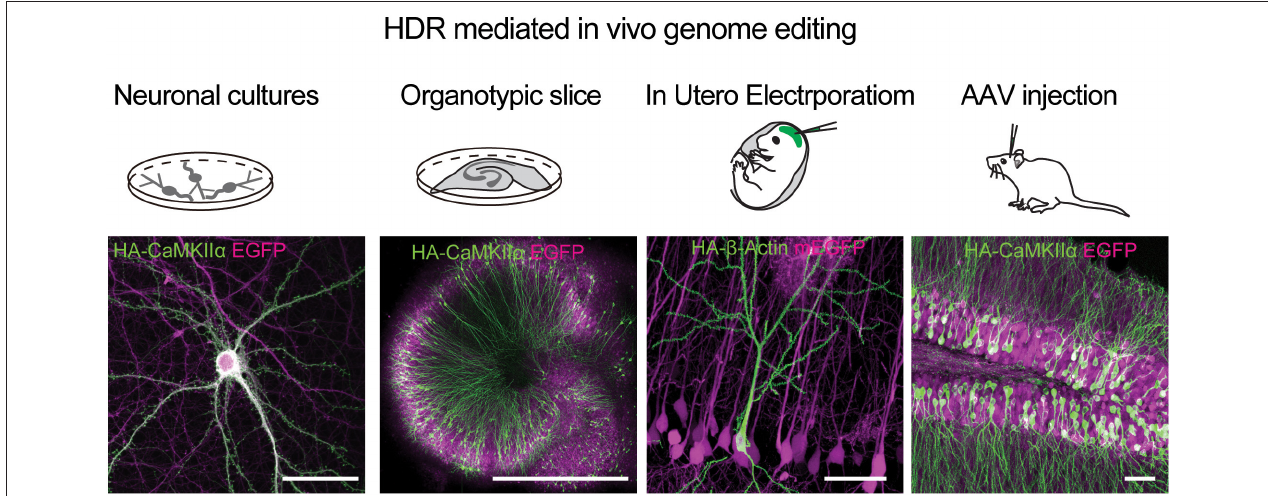
FIGURE 6 | HDR mediated genome editing using SLENDER to label endogenos proteins in the brain. Examples of using vSLENDER in neuronal dissociated cultures (HA-CaMKII-alpha), organotypic slice cultures (HA-CaMKII-alpha), SLENDER using in utero electroporation, (HA-bActin), and AAV injections in the adult mouse brain (HA-CaMKII-alpha). Scale bars are 50 µ m, 1mm, 50 µ m, and 50 µ m, respectively. Images reproduced with permission from Mikuni et al. (2016) and Nishiyama et al. (2017)